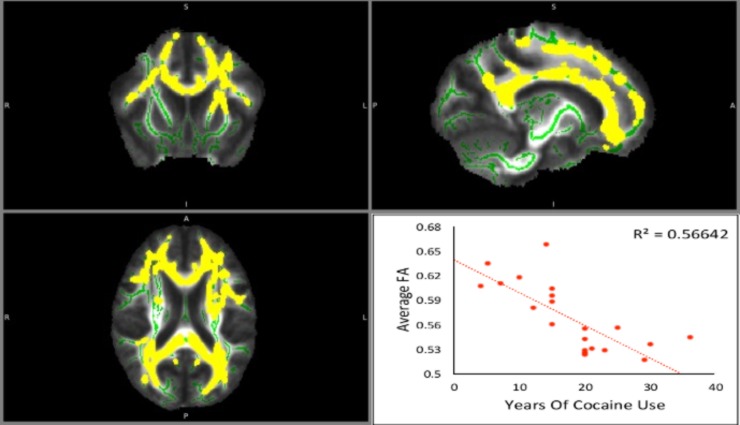
Fractional anisotropy (FA) maps, showing coronal, sagittal, and axial views (respectively) of white matter tracts in 22 CUD/AUD subjects.Major tracts are outlined in green and areas highlighted in yellow represent group-level significant associations with years of cocaine use, controlling for the covariates alcohol use, age, and gender. The bottom right panel shows a scatter plot of average whole-brain FA value (y-axis) as a function of years of cocaine use (x-axis) for individual subjects (R2 = 0.56). Please note the radiological conventions marked on the sides of the Fig 1 for each view: R (right), L (left), S (superior), I (inferior), A (anterior) or P (posterior).